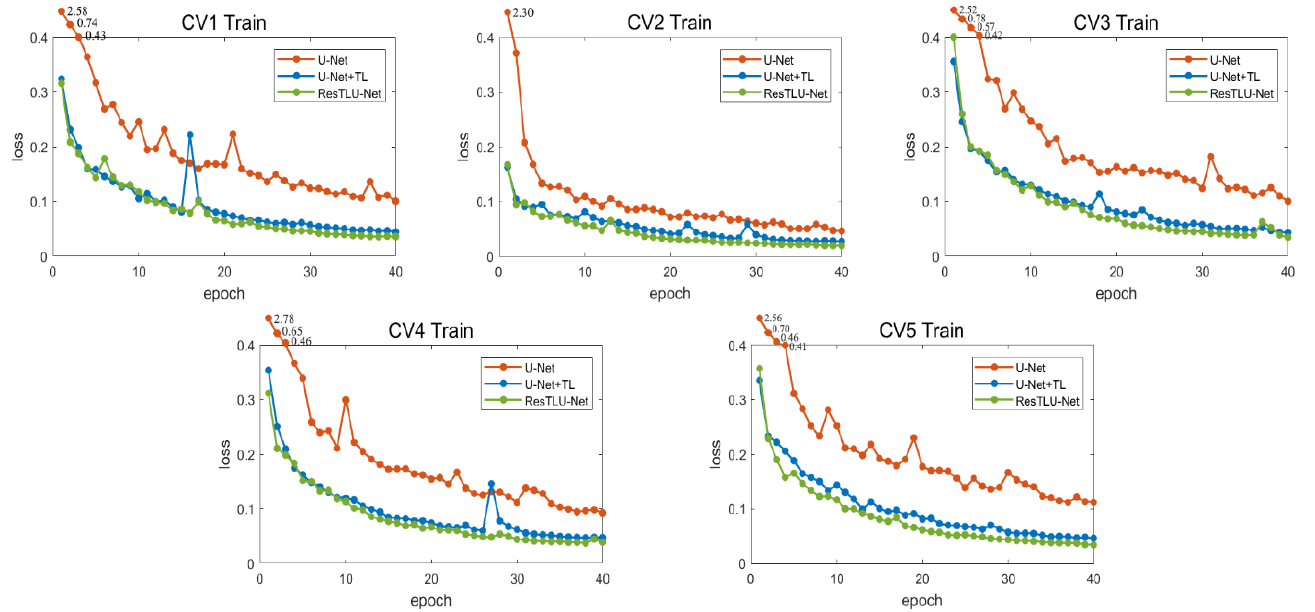
Figure 10. Line charts of loss value change of five-fold cross-validation comparison. The red line represents the change of loss value of U-Net; the blue line represents the change of loss value of U-Net combined with transfer learning; the green line represents the change of loss value of this ResTLU-Net. Each line chart represents the change of loss value during a cross-validation.